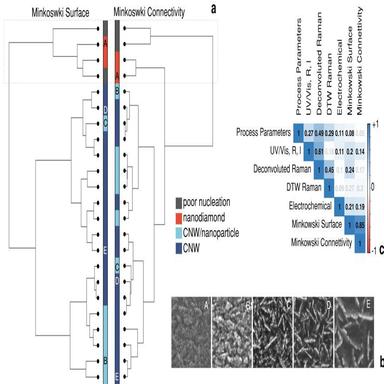
(a) Comparison of the result of hierarchical clustering of two datasets comprising the same samples. Representative SEM micrographs (1 × 1 μm) of the samples (b) are reported along the dendrograms. (c) Correlation (gamma index) between different clusters.